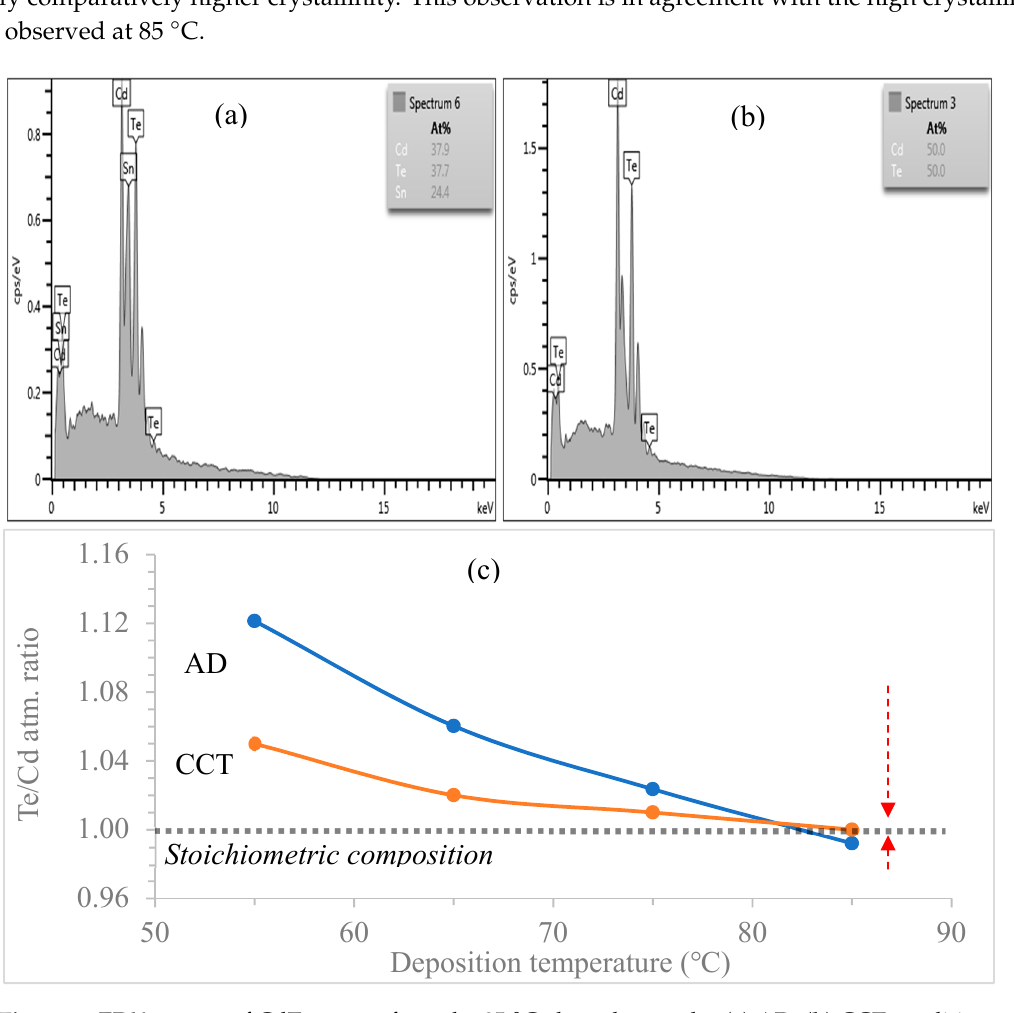
Figure 9. EDX spectra of CdTe grown from the 85 °C electrolyte under ( a ) AD, ( b ) CCT conditions ( c ) is the graphical summary of Te/Cd atomic composition ratio against electroplating temperature of CdTe for both AD and CCT samples.